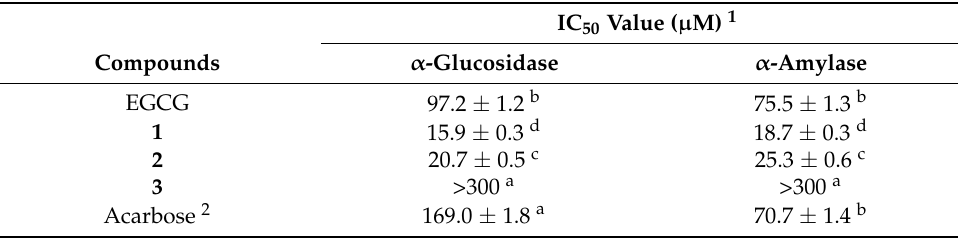
Table 2. α -Glucosidase and α -amylase inhibitory effects of oxidation products 1 – 3